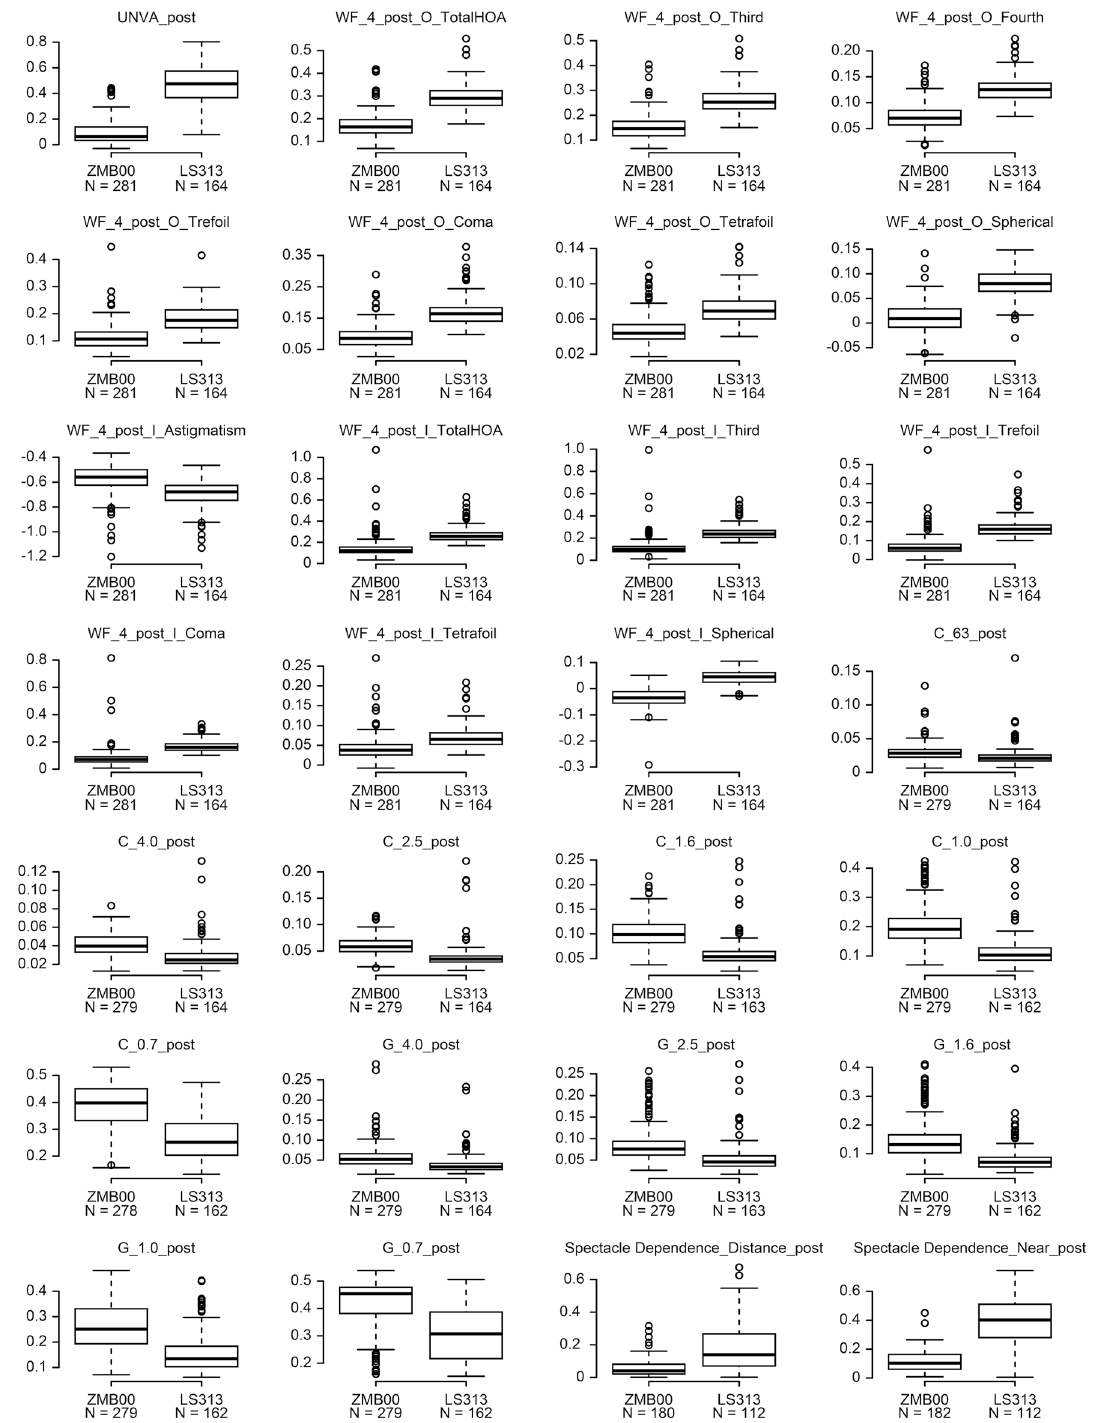
Figure 1. Parameters differing significantly between the diffractive bifocal (TECNIS ZMB00) and rotationally asymmetric refractive (Lentis Comfort LS-313 MF15) groups 10 weeks after surgery in both eyes. The line inside the box represents the median. To highlight outliers, the upper whisker is set to the maximum or the third quartile + 1.5 × IQR. The lower whisker indicates the minimum or the first quartile–1.5 × IQR. Each parameter was adjusted by multiple regression with the explanatory variables listed in Table 1. The two-sided Wald test was applied to evaluate the significance of differences between the two groups, and the significance level was set to 0.00068 using Bonferroni’s correction. UNVA: uncorrected near visual acuity; WF_4_post_O_: wavefront_4_ post_ocular; WF_4_post_I_: wavefront_4_post_internal; HOA: higher-order aberration; C: contrast sensitivity; G: contrast sensitivity with